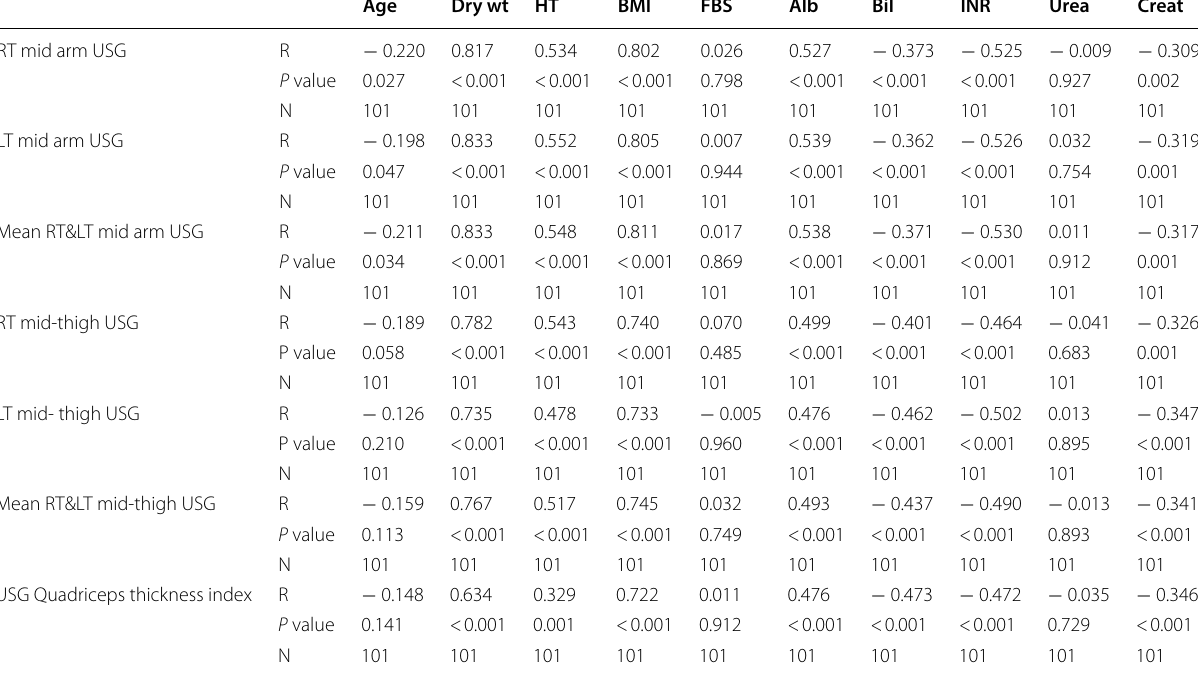
Table 12 Correlation between ultrasound muscle thickness quadriceps muscle index and anthropometric measurement and laboratory